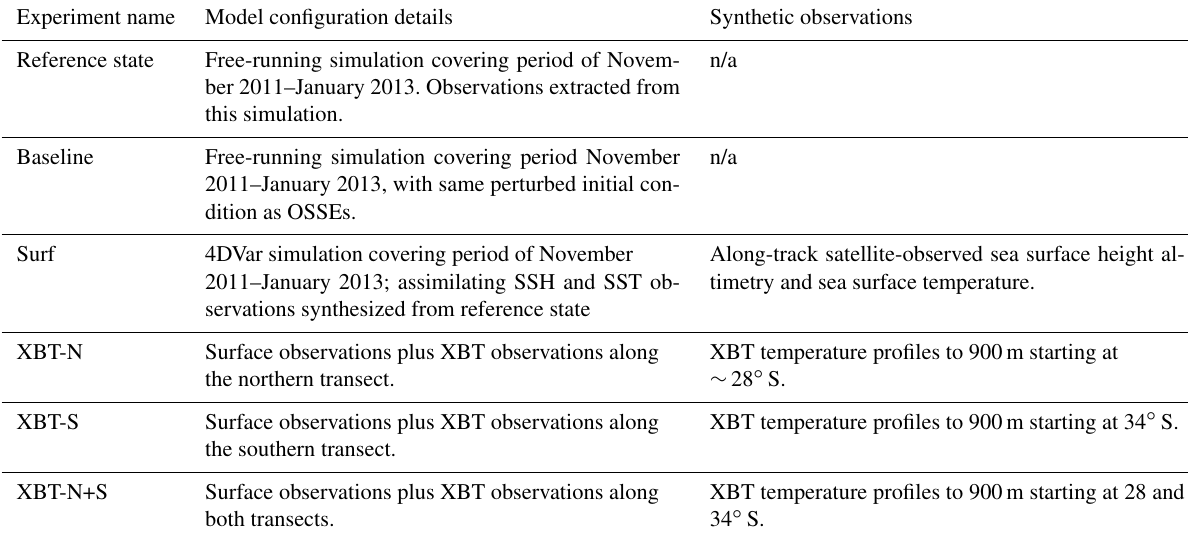
Table 1. Features of each OSSE are shown, including the model configuration and the details of the synthetic observations. Horizontal spacing of the XBT profiles are described in Sect. 2.3, and spacing of typical SSH and SST data is shown in Fig. 3a.